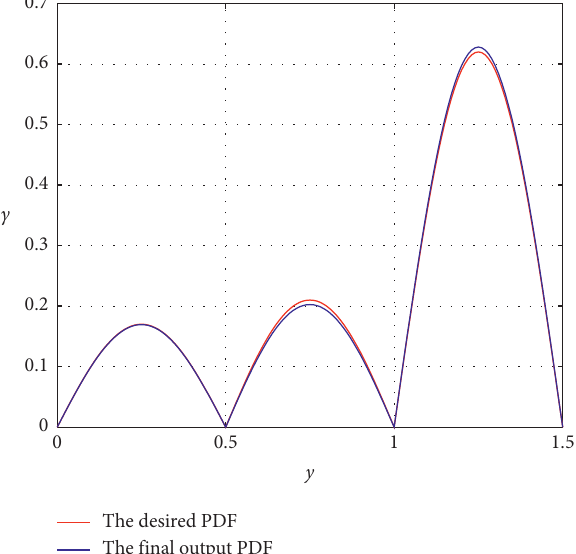
Figure 15: The expected output PDF and the final output PDF with the first-order sliding mode FTTC